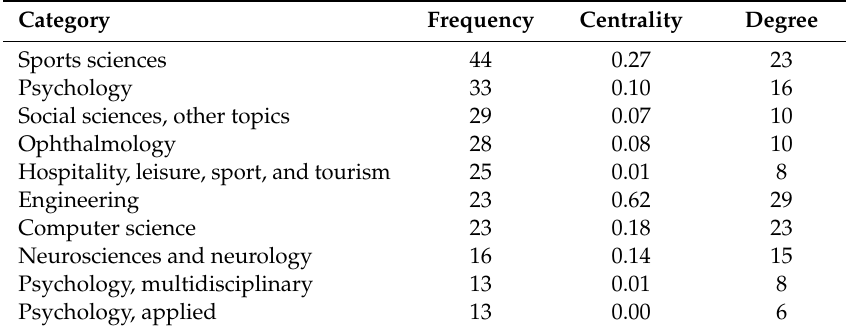
Table 2. Number of publications by research area.